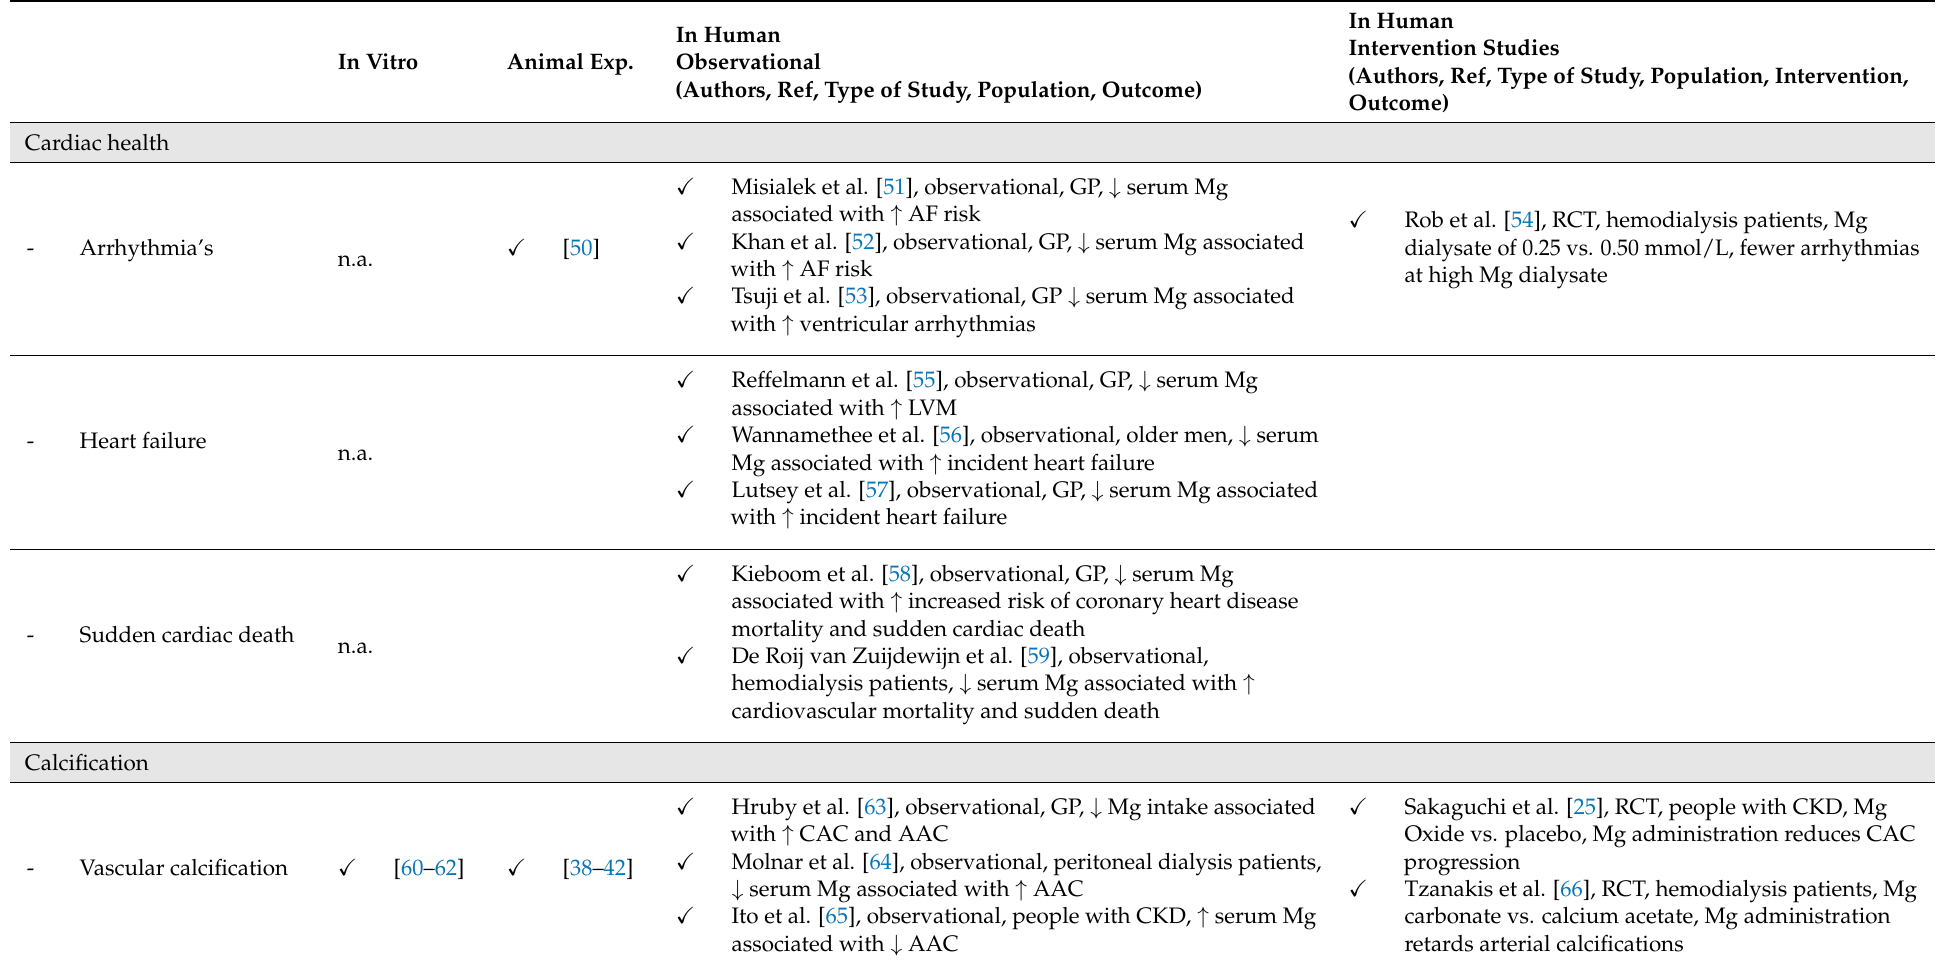
Table 2. Summary of discussed results that support a rationale for Mg administration in CKD.